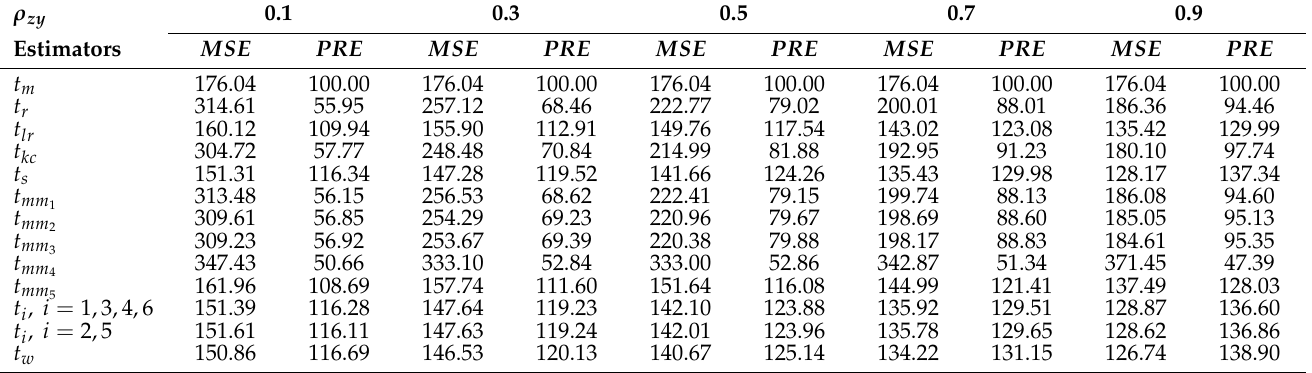
Table 5. MSE and PRE of estimators using exponential population.